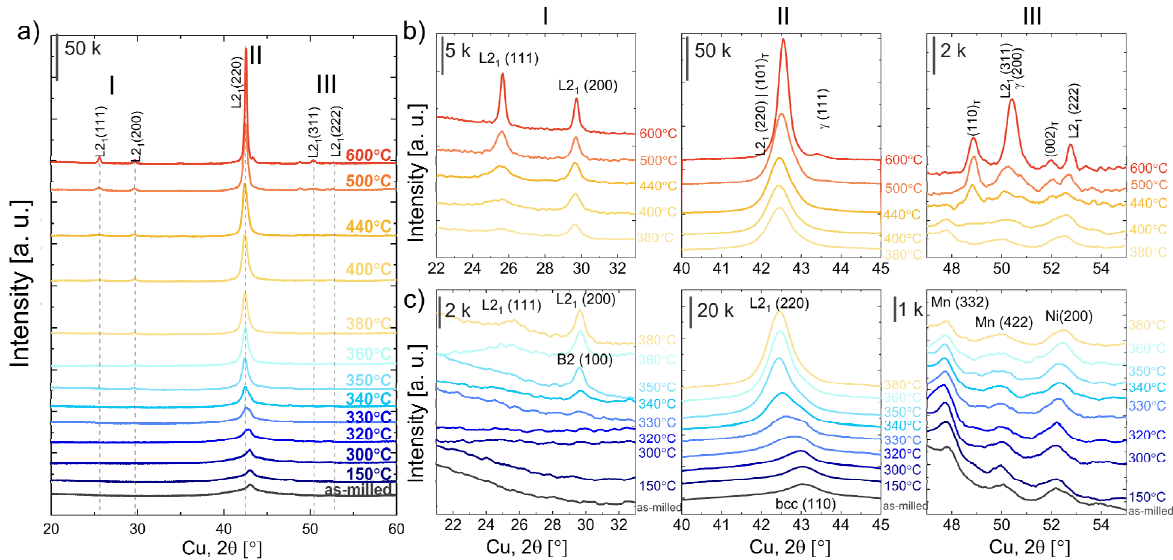
Figure 9. ( a ) XRD diffraction patterns of as ‐ milled and annealed 100MA powders, 2 θ ranges: (I) 21– (I) 21–33 ◦ 2 θ , (II) 40–45 ◦ 2 θ , and (III) 47–55 ◦ 2 θ . For better clarity, XRD results are presented 33° 2 θ , (II) 40–45° 2 θ , and (III) 47–55° 2 θ . For better clarity, XRD results are presented separately for